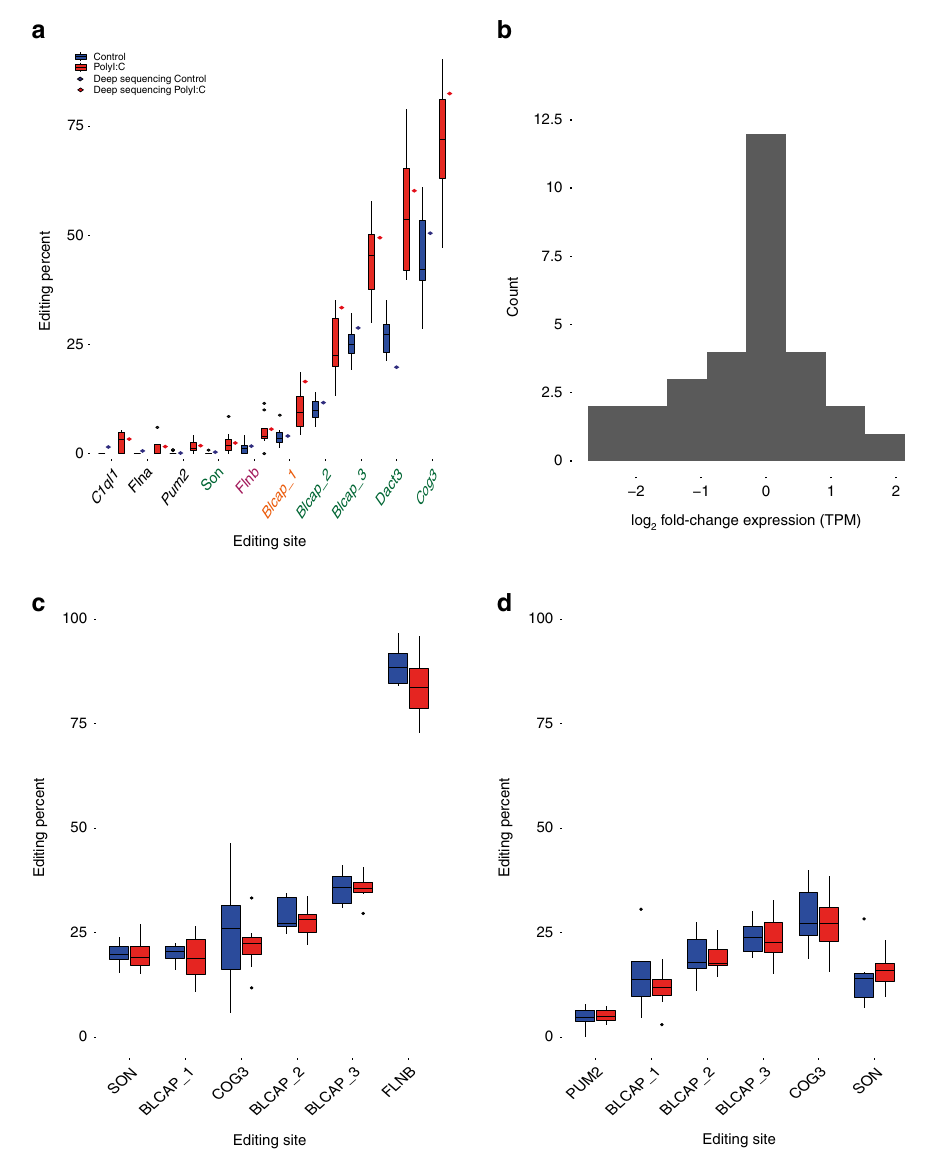
Fig. 4 Increased levels of A-to-I RNA editing in recoding sites in PolyI:C mice. a RNA editing levels were measured in a set of 59 evolutionarily conserved coding editing sites. Only sites with at least 10 reads sequencing coverage were considered reliable. Ten sites that satis fi ed the condition exhibited a signi fi cant increase in editing levels in the PolyI:C group ( n = 8) compared to controls ( n = 11) (two-sided wilcoxon rank test followed by the Benjamini – Hochberg false discovery rate (FDR) multiple testing (0.1)). For each site, editing levels of deep sequenced samples (see “ Methods ” ) are also indicated. The ADAR type 41 responsible for the editing site is indicated as orange for ADAR1 speci fi c, green for shared ADAR1 and ADAR2, and pink for ADAR2. The levels of editing obtained from the deep sequencing samples are indicated with a rhombus by each site. b Log 2 fold change of gene expression levels (PolyI:C/control) for 30 genes (TPM > 1) harboring the 59 conserved editing sites (average log 2 fold change = − 0.28). c Editing level analysis on the 59 conserved editing sites for older PolyI:C ( n = 9) and control ( n = 8) mice. The plotted sites are those that overlapped with the differentially expressed sites detected. Represented samples are the frontal cortex of mice subjected to MIA treatment at GD12.5 and sequenced at PD189. d Amygdala samples from mice subjected to MIA treatment at GD9 ( n = 10) and control ( n = 10) and sequenced at 12 weeks of age. All distributions are presented as box-and- whisker plots (center line, median; box limits correspond to the fi rst and third quartiles; whiskers, 1.5× interquartile range and points, outliers). Source data are provided as a Source Data fi